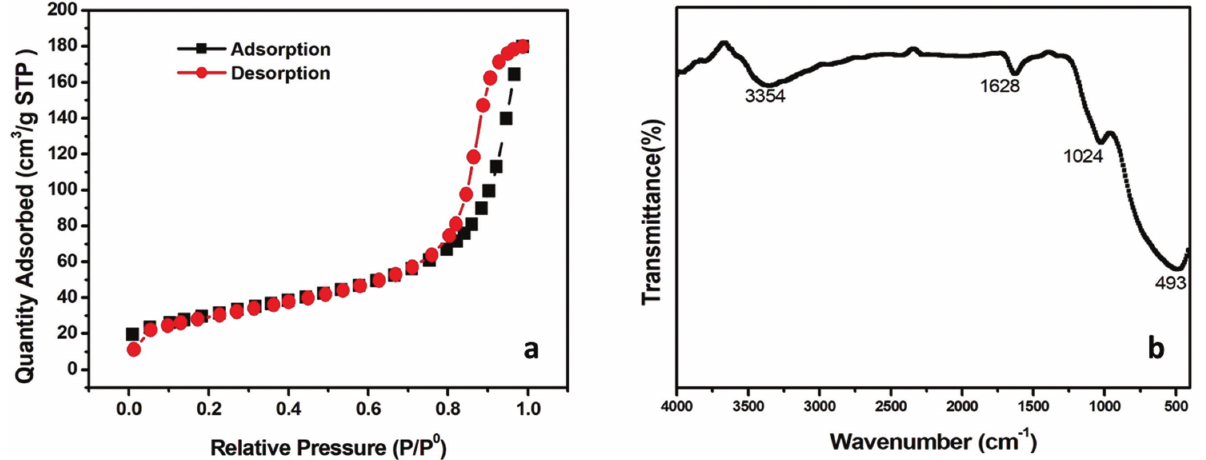
Figure 4: (a) Adsorption- desorption isotherms curve of the synthesized nanoparticle; (b) FTIR plot of synthesized TiO